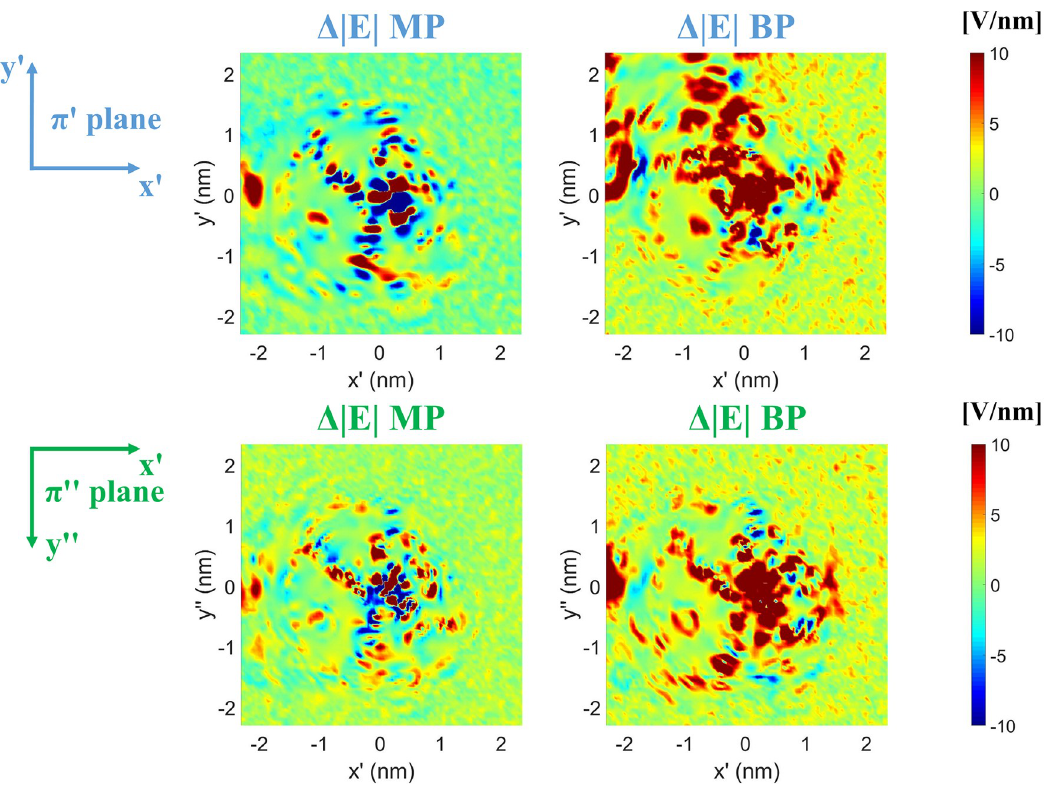
Fig 7. 2D-maps of the local electrostatic field modification around the active site. Electric field effects on the π ’ and π ” planes, due to both MP (first column) and BP (second column) signals, are